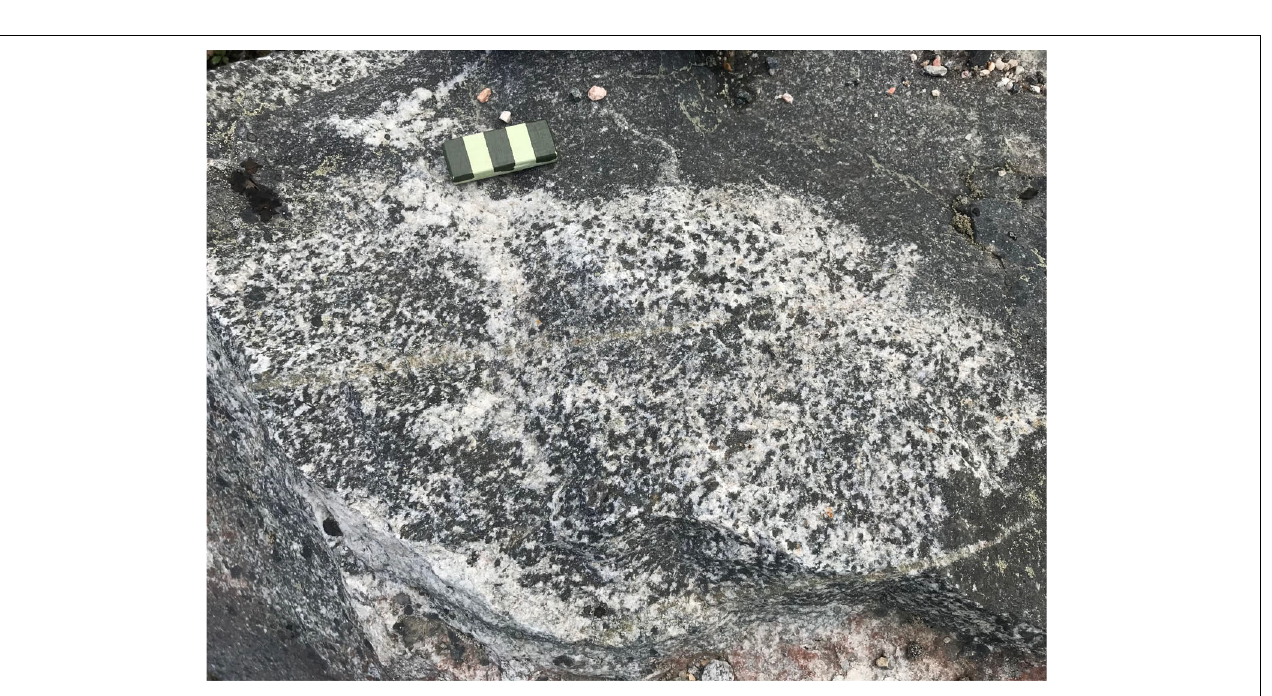
Frontiers in Earth Science | www.frontiersin.org